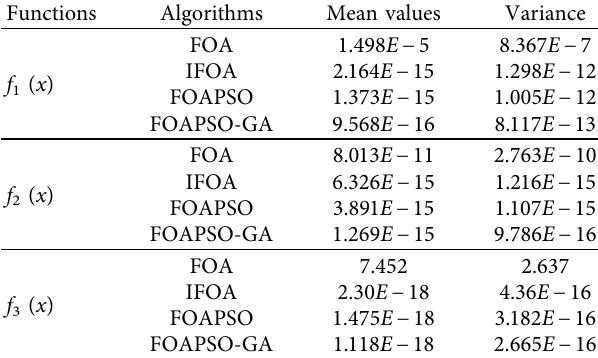
Table 4: Algorithm validity